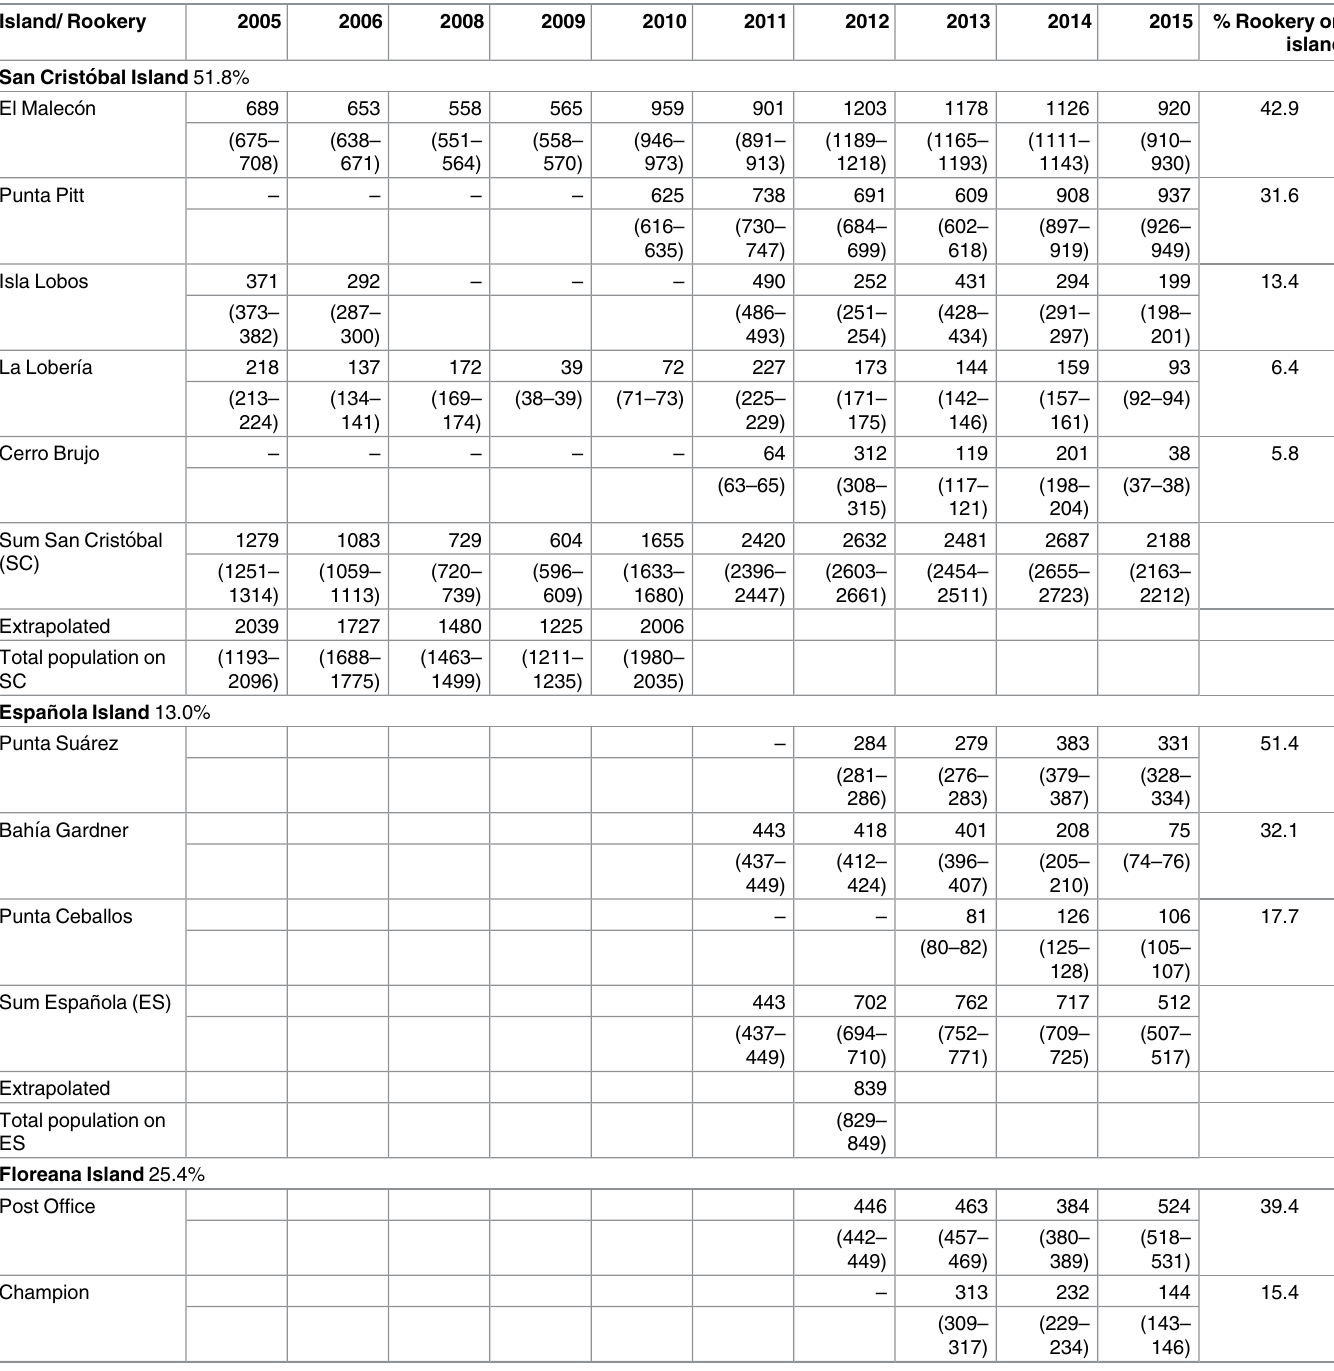
Table 1. Galapagos sea lion population sizes in breeding rookeriesin the southeastern region (SER) of the archipelago. Estimated values are basedon corrected census data using correction factors for different age categories. The 95% confidenceintervalof each estimate is shown in parentheses. The averagepercentage of each island’spopulation with respect to the SER is shownnext to the nameof the island.The averagepercentage of the population representedby each rookery relative to the islandis shown in the last column. Both percentagevalues were used to extrapolate the total population size per island and in the SER in those years duringwhich there were missing data and the censusedpopulation was (cid:21) 46%. Island/